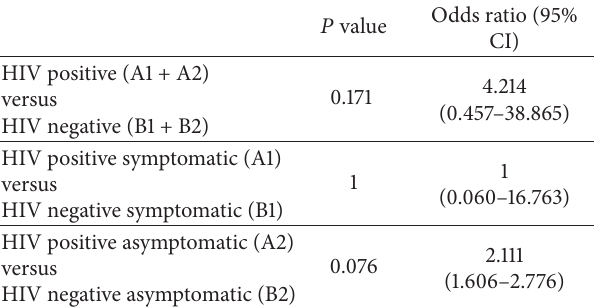
Table 6: Correlation between HIV positivity and presence of CTI among women with and without